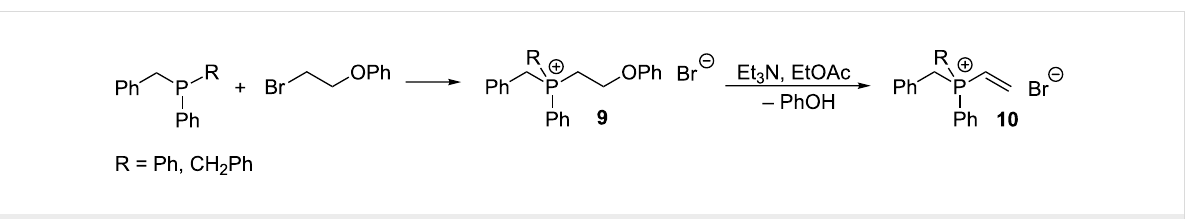
Scheme 9: β -Elimination of phenol from β -phenoxyethylphosphonium salts in an alkaline environment.